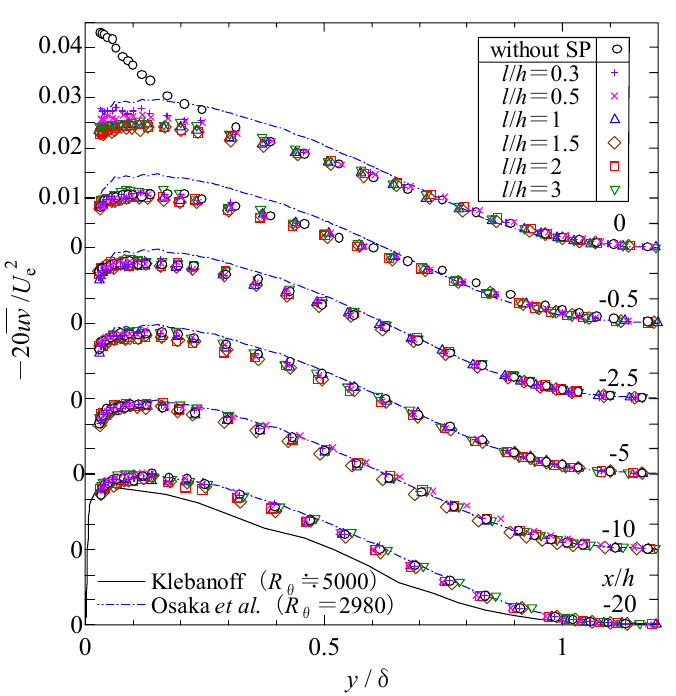
Fig. 4 Reynolds shear stress